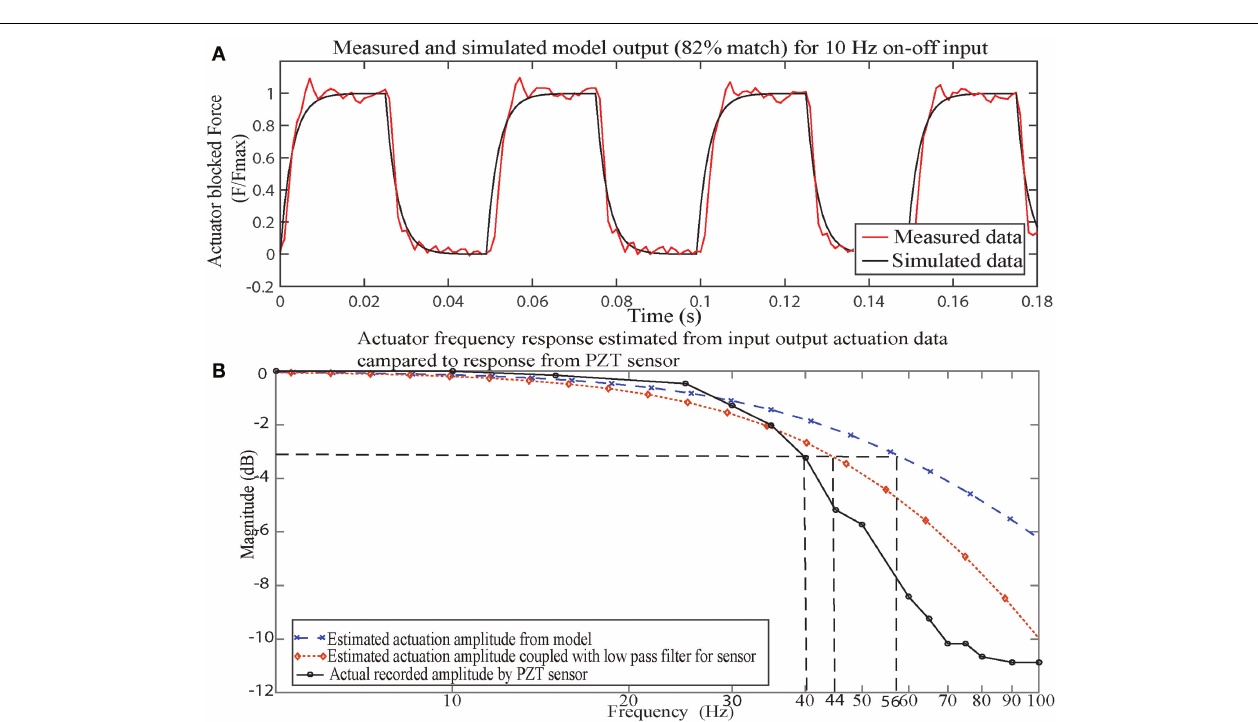
FIGURE 3 | Silicone-embedded PZT sensor characteristics . Silicone-integrated PZT sensor response (A) obtained for a 10Hz stepped force input of different amplitude. Test setup with Nano -17 force sensor used for the PZT sensor and soft actuator characterization (B) . The Nano -17 sensor position can be adjusted precisely in the z-direction to accommodate the exact thickness of SPA skin.